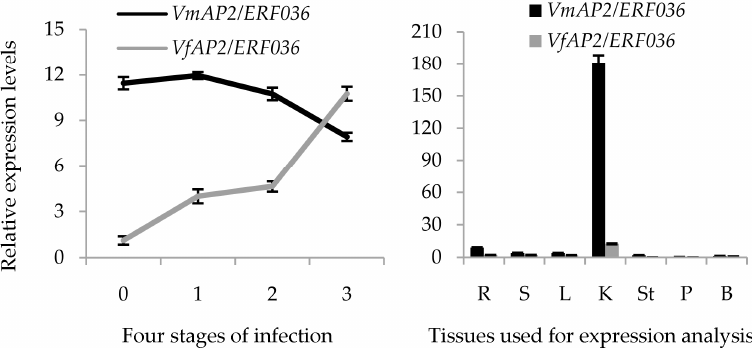
Figure 8. ( left ) Expression trend in response to F. oxysporum . The numbers in the x -axis represent the four stages of infection, as follows: 0, uninfected stage; 1, early stage of infection; 2, middle stage of infection; 3, late stage of infection. ( right ) Tissue specific expression pattern analysis of VfAP2 / ERF036 / VmAP2 / ERF036 in root (R), stem (S), leaf (L), kernel (K), stamen (St), petal (P) and bud (B) tissues. The y -axis represents relative expression level. Expression level was analyzed using qRT-PCR in triplicate.